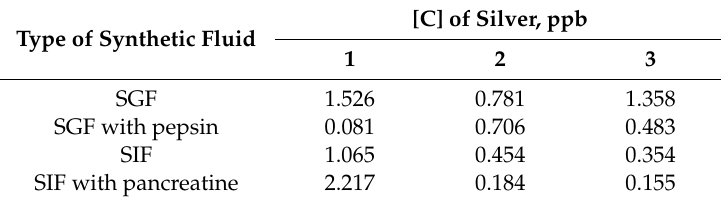
Table 4. Concentrations of Ag + ions after evaluation of casein-silver (Ag-CN) complex in di ff erent synthetic physiological fluids measured by Inductively Coupled Plasma Mass Spectrometer